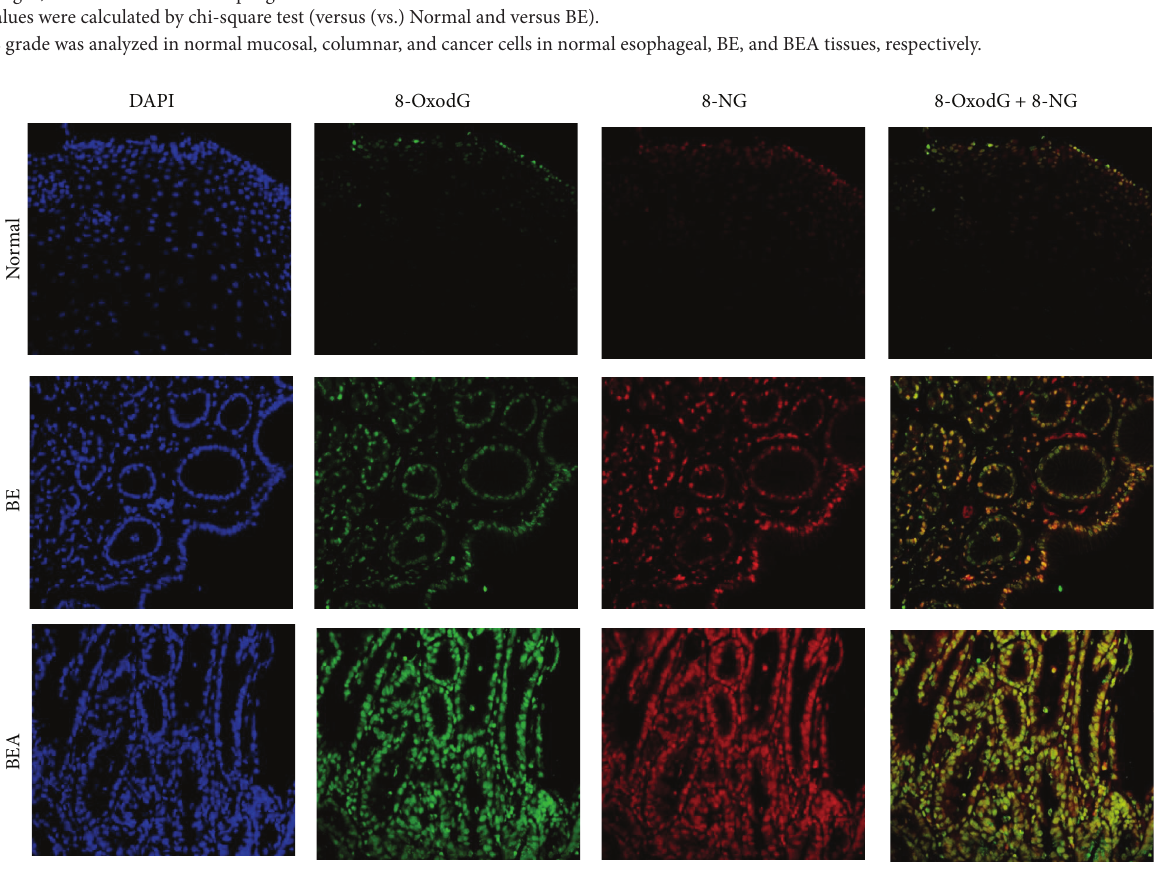
Figure 2: Double immunofluorescence staining of mutagenic DNA lesions in normal esophageal (Normal), Barrett’s esophageal (BE), and Barrett’s esophageal adenocarcinoma (BEA) tissues. Nucleus was stained in blue (DAPI). 8-OxodG was stained in green and 8-nitroguanine (8-NG) was stained in red. The original magnification is ×